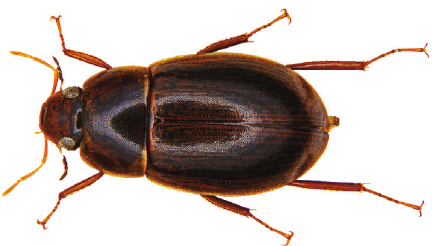
Figure 29. Helochares dilutus (Erichson, 1843) 6.8 mm, iSimangaliso Wetland Park, False Bay (site 27), January 2015 DT Bilton, MS Bird & R Perissinotto